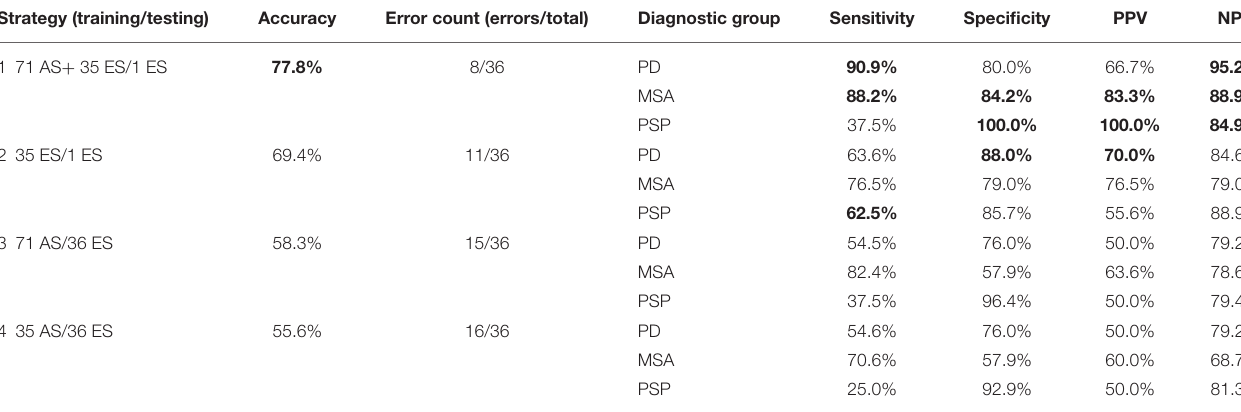
TABLE 5 | Diagnostic performances of the four different training strategies. Strategy (training/testing)